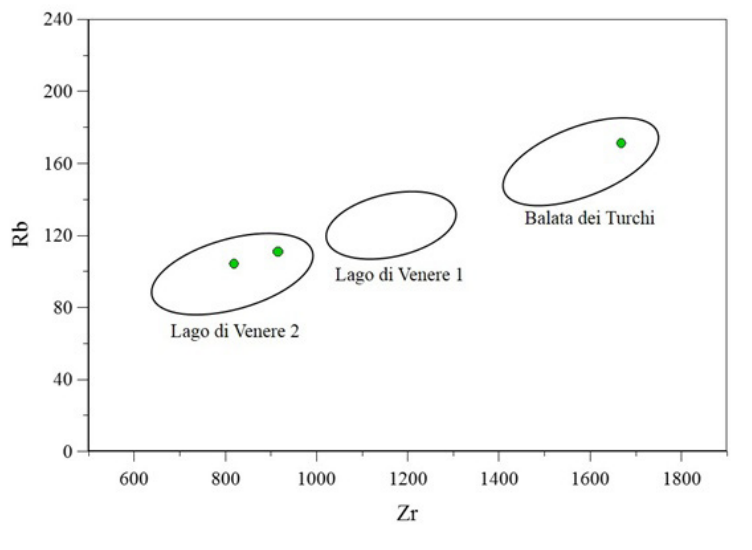
Figure 11 . Graph of Rb and Zr values (in ppm), showing assignment of Pantelleria artifacts to two of three subgroups depicted as ellipses based on many geological samples analyzed with the same